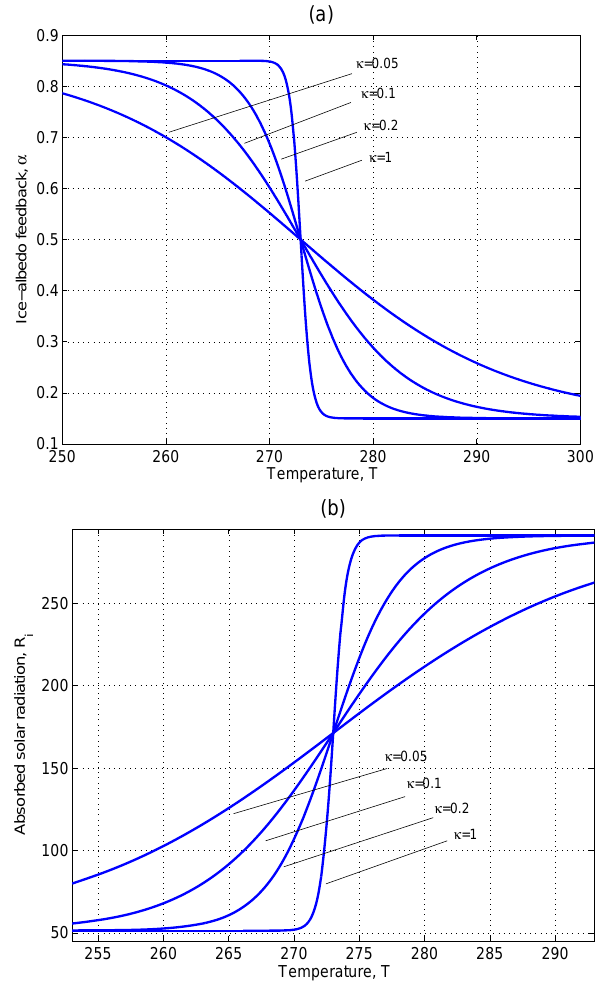
Fig. 3. Dependence of the absorbed incoming radiation 𝑅 i on the steepness parameter 𝜅 : (a) ice-albedo feedback 𝛼 = 𝛼 ( 𝑇 ; 𝜅 ) , and (b) absorbed radiation 𝑅 i = 𝑅 i ( 𝑇 ; 𝜅 ) , for different values of 𝜅 ; see Eqs. (12) and (13).